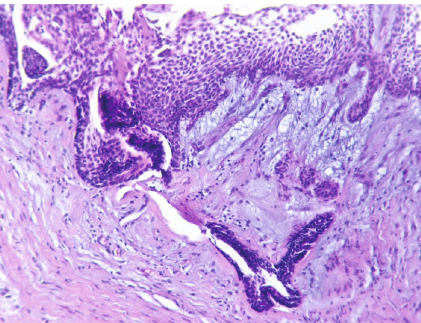
Figure 8: Optical microscopic picture showing the invagination of the ameloblastomatous epithelium inside the fi brous wall with the presence of clusters of ameloblast inside the wall. Stained with hematoxylin and eosin, magni fi ed 60 times.